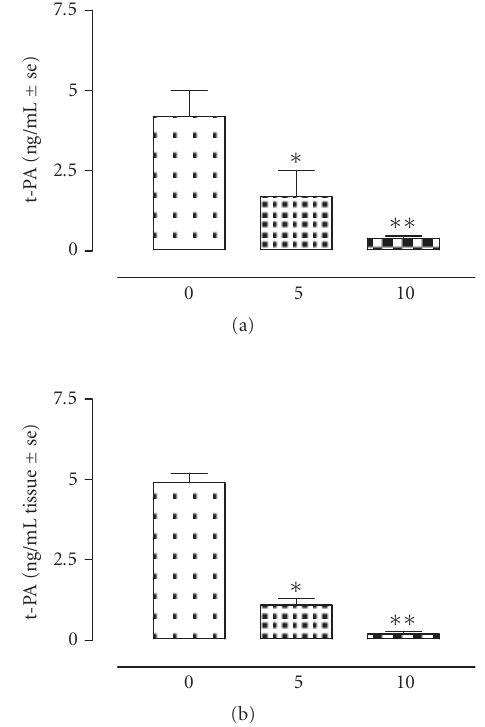
Figure 1: t-PA levels in rats ( n = 8) subjected to experimental peri- toneal adhesion development. The time is expressed in days. Sig- nificant di ff erences from time 0 values are expressed as ∗ P < . 01; ∗∗ P < . 001.